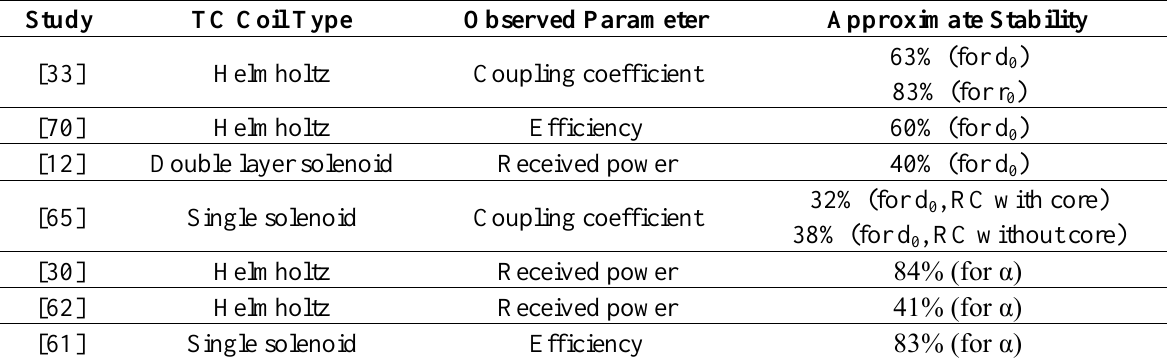
Table 6. Overview of WPT system